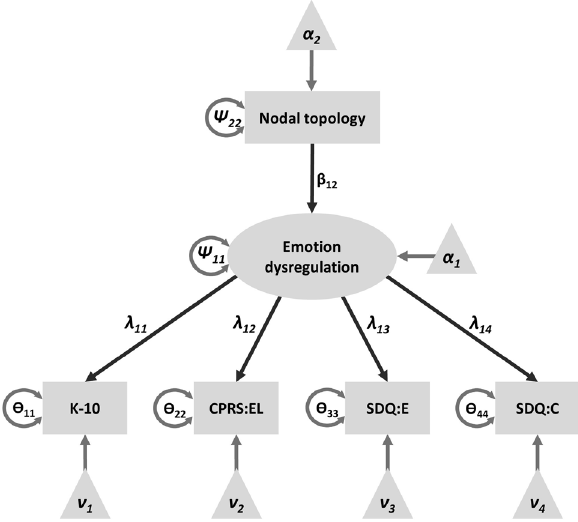
Figure 3. Multi-group structural equation model. Variances (V 1 –V 6 ) and intercepts (I 1 –I 6 ) are group specific. Loading parameters (p 1 –p 4 ) are fixed across groups while the regression parameter (p 5 ) is group specific. The model is compared to a model with fixed p 5 ; LV: latent variable for emotion dysregulation; K-10: Kessler Psychological distress scale, NESDA version of K-10; CPRS: EL: Conners’ parent rating scale, revised, long version, emotional lability subscale; SDQ: E: Strength and Difficulties Questionnaire, emotional symptoms subscale; SDQ: C: Strength and Difficulties Questionnaire, conduct symptoms subscale. Figure was created using Microsoft PowerPoint 2016 MSO (version 16.0.4266.1001, https:// www. micro soft. com/ de- de/ micro soft- 365/ power